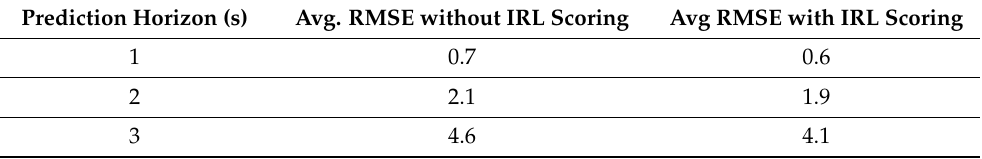
Table 6. RMSE by prediction